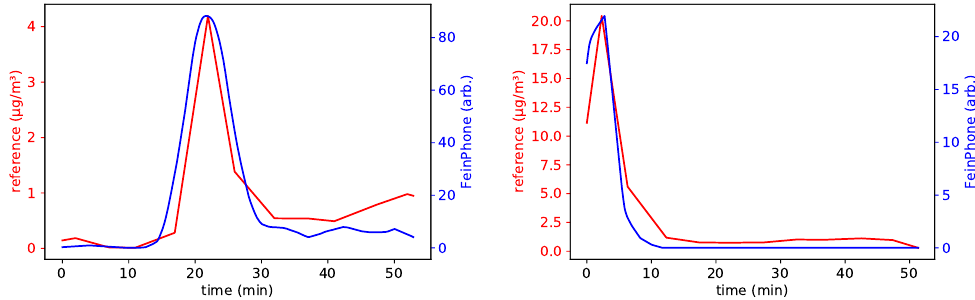
Figure 8. Particle counts obtained from the CDPC algorithm vs. reference signal (PM ( 10 fraction) for sensors B005 ( left ) and B001 ( right ). CDPC parameters: r learn : 0.1, θ contour : 100.0.